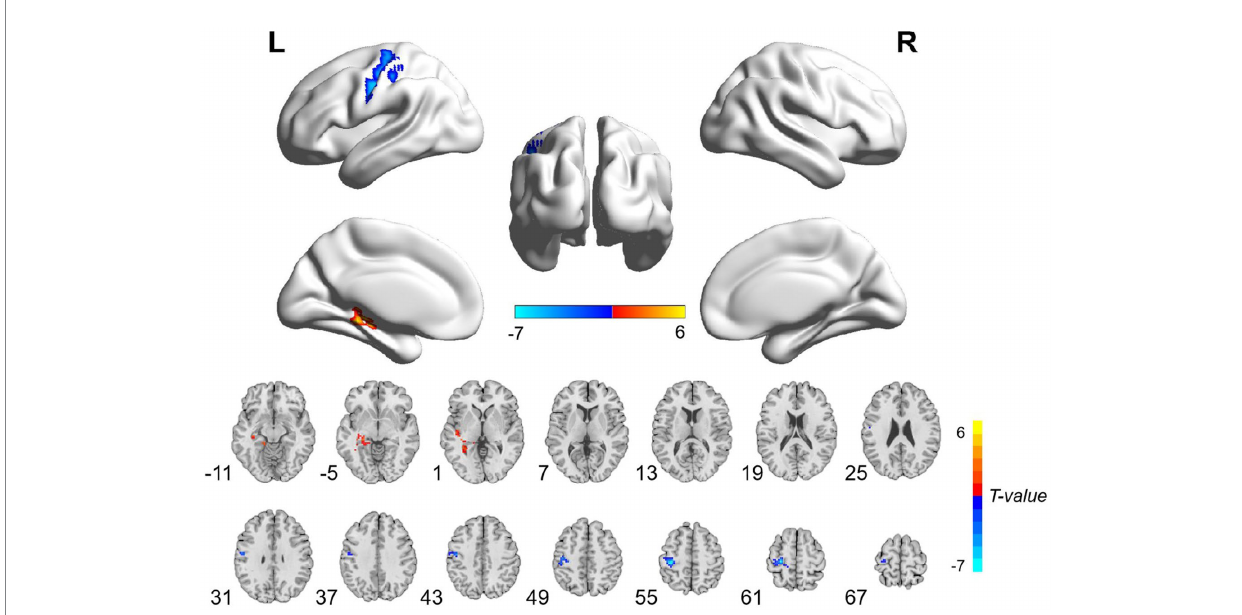
FIGURE 1 Brain regions with significant ALFF differences between patients with cardiac arrest and healthy controls. The patient group showed significantly decreased ALFF values in the left postcentral gyrus and precentral gyrus and increased ALFF values in the left hippocampus and parahippocampal gyrus